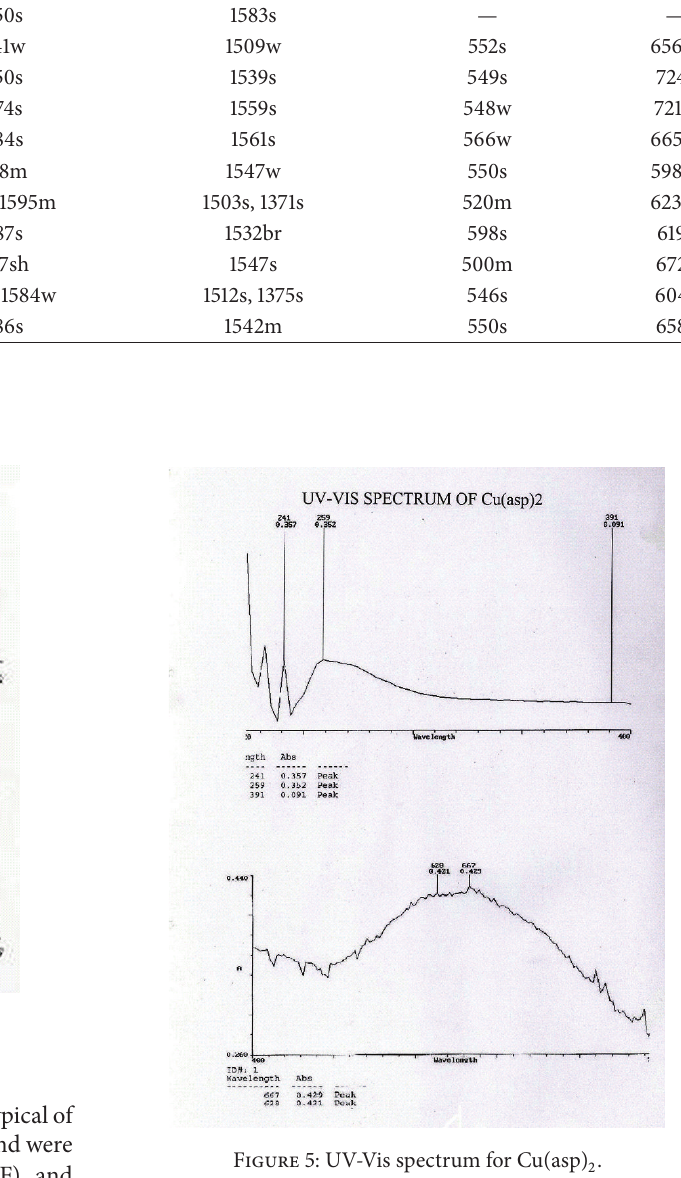
Figure 5: UV-Vis spectrum for Cu(asp) 2